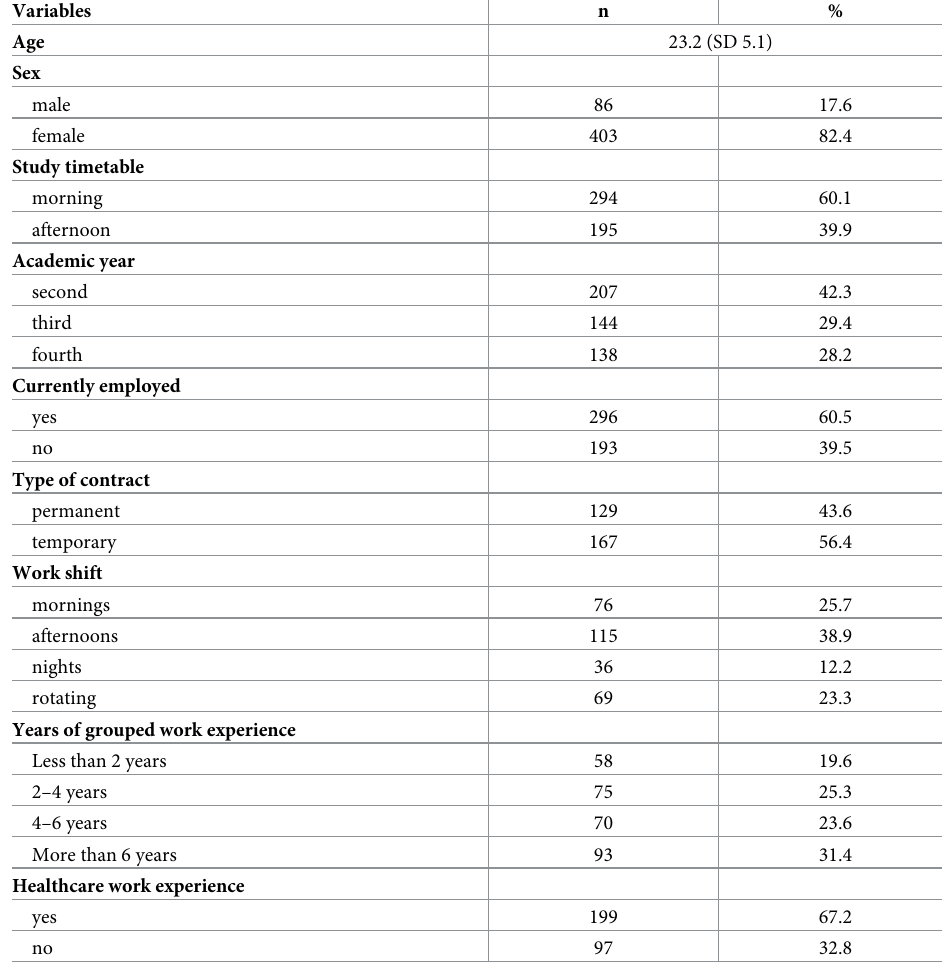
Table 2. Sociodemographic characteristics of the study